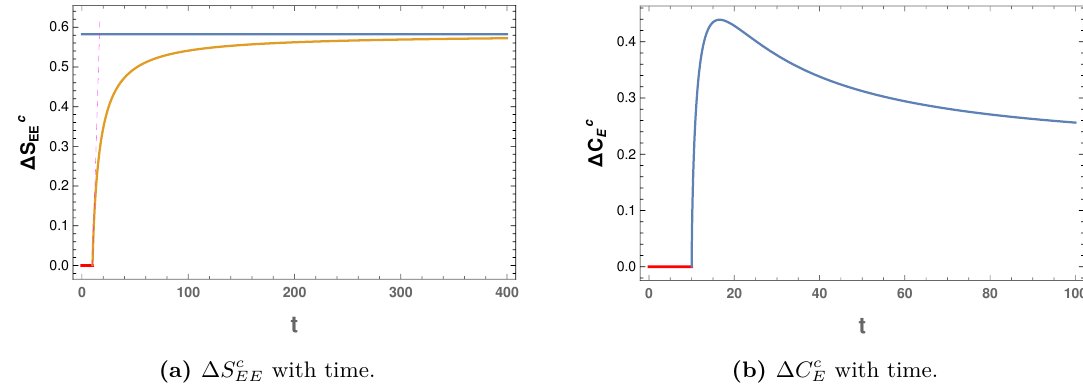
Figure 7. Plot of (a) entanglement entropy and (b) capacity of entanglement for ( γ t γ 1 ) aa = 0 for the charged case. Here we choose L = 10 and µ = 1 / 2 π . At t ≈ 16 . 5518 , capacity reaches a peak where the “Page transition” occurs. Note that capacity does not vanish at late times. Instead, it reaches a constant value ∆ C c,f = 0 . 1996612 at late times. The late time entanglement entropy E saturates to ∆ S c,f = 0 . 5822 . Again these plots closely resemble the EoW brane model in the EE canonical ensemble